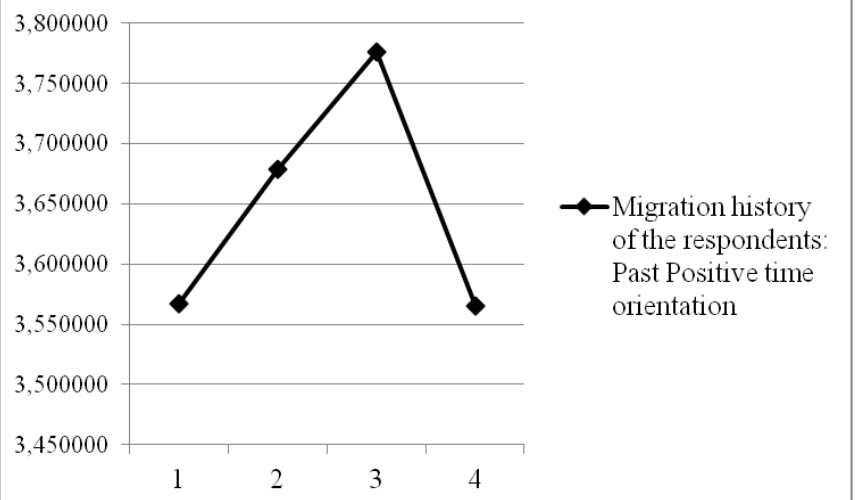
Fig. 3. Average values according to the scale „Past Positive” in subgroups divided on the basis of migration history of the respondents: 1 – residents of oblast centres including those who spent their childhood there as well as those who came to an oblast centre from a small town (n = 278), 2 – residents of small towns who had grown up there (n = 55), 3 – those respondents who spent their childhood and currently live in villages (n = 70), 4 – residents of oblast centres who spent their childhood in a village or town-like settlement (n =